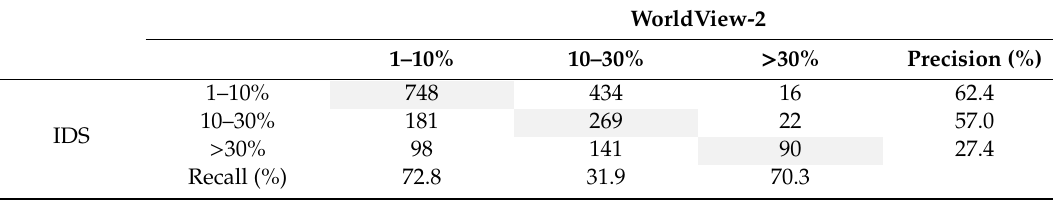
Table A6. Comparison of percent tree mortality area derived from 2018 WorldView-2 and IDS polygons (2014–2018 cumulative). IDS trees per acre measurements were converted to percent mortality using the FHP method. Overall accuracy = 55.4%, N =